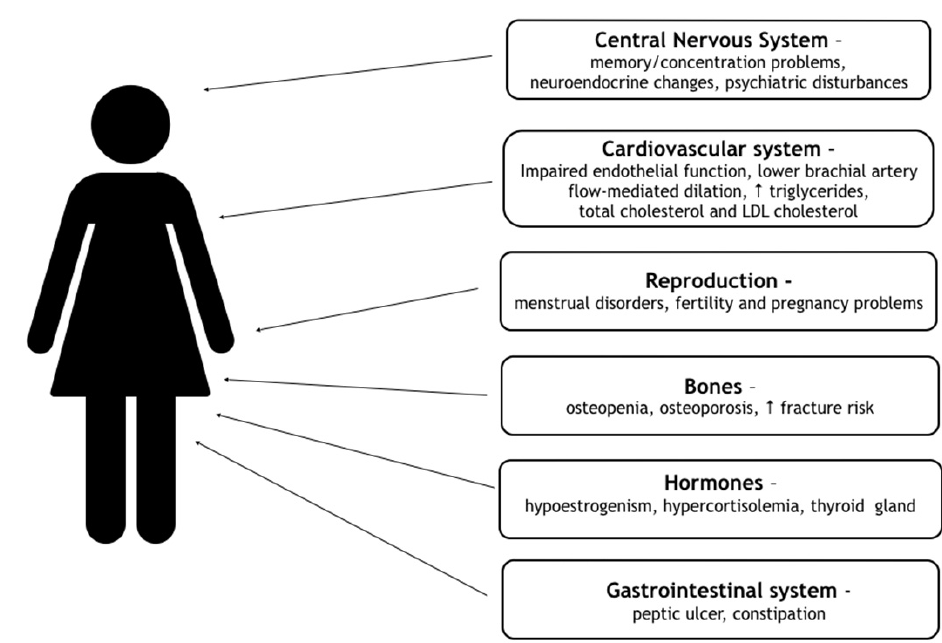
Figure 1. Consequences of FHA. ( ↑